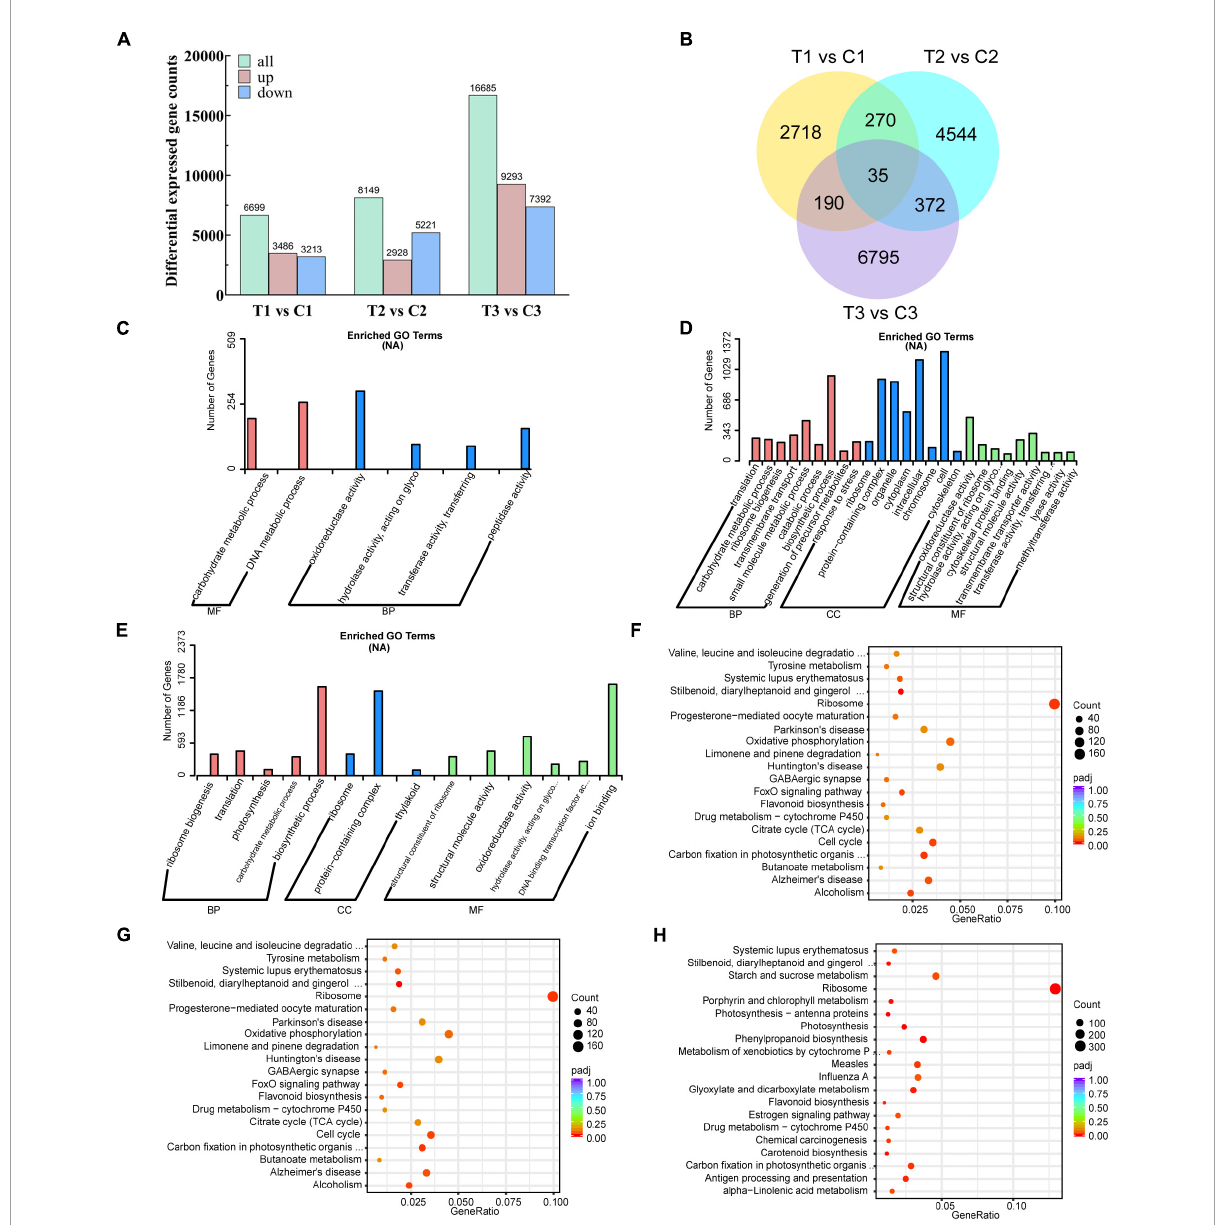
FIGURE3 Transcriptomics analysis of P. cyrtonema seed at different stages. (A) Number of DEGs per comparison (both upregulated and downregulated). (B) Venn diagram showing the DEGs in the three comparison combinations. (C) GO annotation of DEGs of comparison group T1 vs. C1. (D) GO annotation of DEGs of comparison group T2 vs. C2. (E) GO annotation of DEGs of comparison group T3 vs. C3. (F) KEGG annotation of DEGs of comparison group T1 vs. C1. (G) KEGG annotation of DEGs of comparison group T2 vs. C2. (H) KEGG annotation of DEGs of comparison group T3 vs.